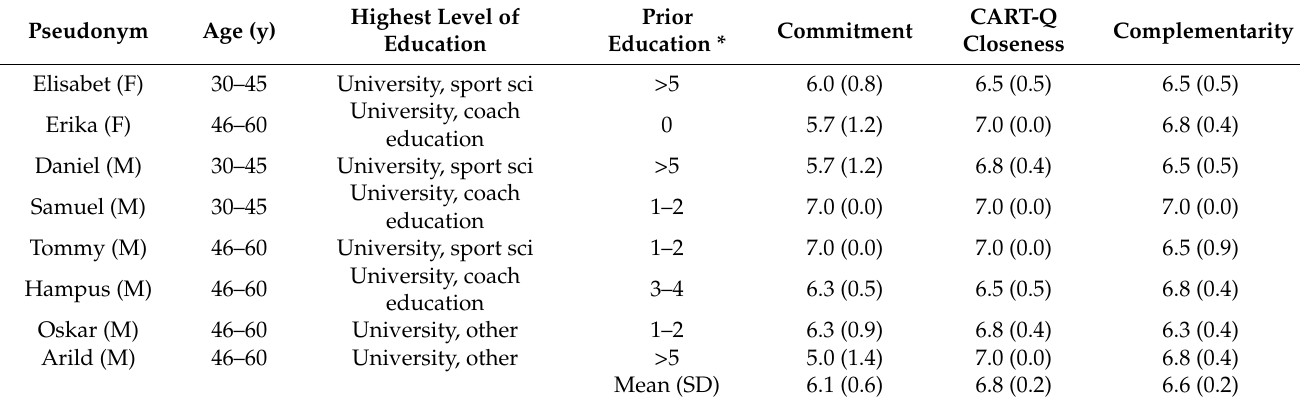
Table 2. Descriptive data for the female (F) and male (M) coaches relating to age, educational level, prior education * and mean (standard deviation, SD) coach–athlete relationship (CART-Q)